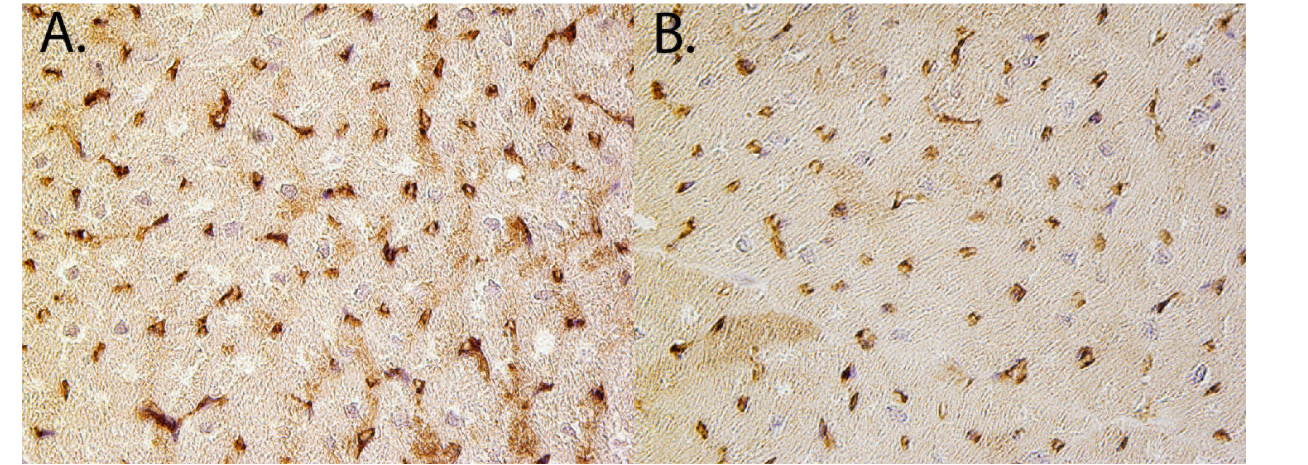
Fig 7. Vascular density. Respresentative picutures of Lectin staining of the borderzone of a CMCP treated animals (A) and a placebo animal (B)